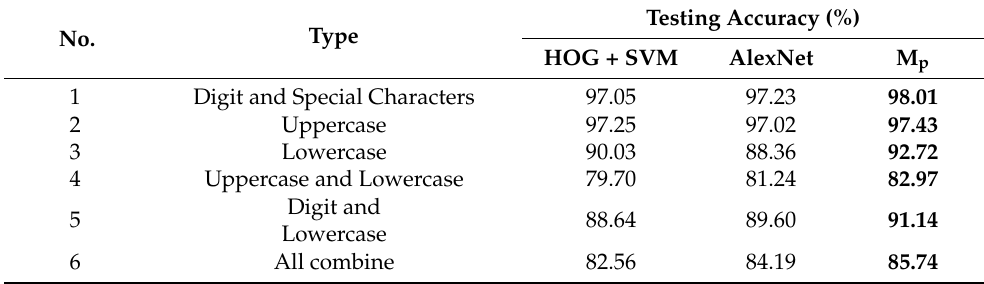
Table 5. Comparison of testing accuracies with other compared models.